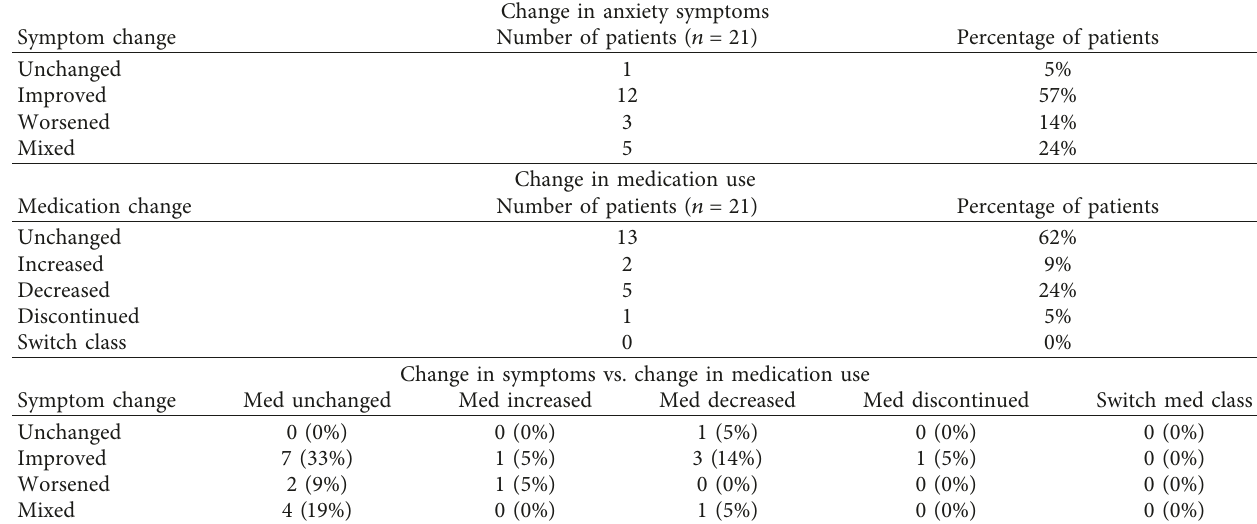
Table 3: Change in anxiety symptoms compared to change in medication use ( n �